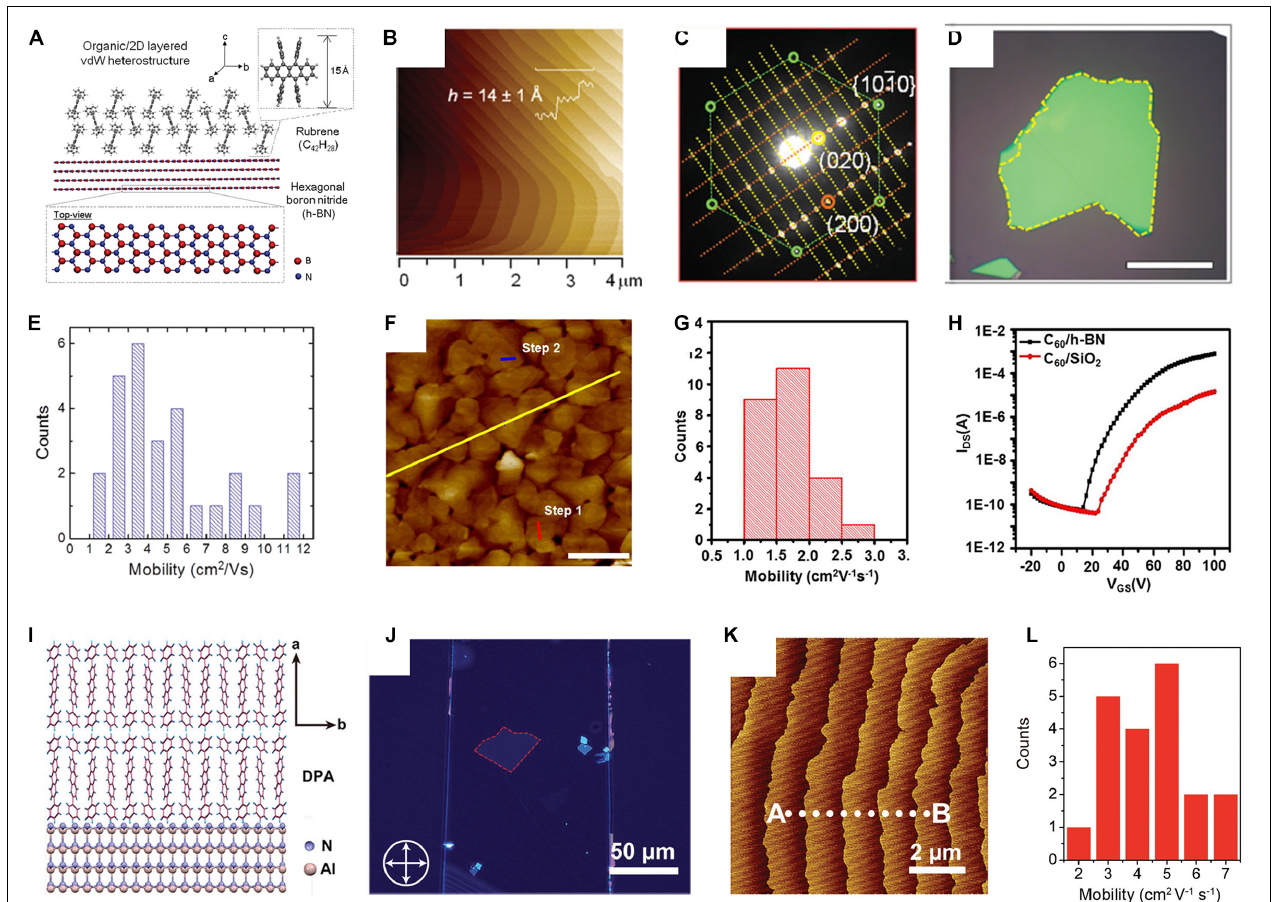
FIGURE 4 | OSCs/2D hybrid FETs with 2D materials as growth templates and insulating layers. (A) The packing mode of the rubrene/h-BN heterostructure. (B) AFM height image of the rubrene terraced film. A step height of 14 ± 1 Å is indicated. (C) Bright-field TEM image and selected-area electron diffraction pattern of the rubrene crystal grown on h-BN. The orange, yellow, and green circles corresponds to (200) rub , (020) rub , and h-BN planes, respectively. (D) Large single-crystalline domain of rubrene crystalline films grown on h-BN flakes by polarization optical characterization. The scale bar is 20 µ m. (E) Histogram of mobility of rubrene/h-BN OFET devices with graphene contacts. Reproduced from Lee et al. (2014) with permission from Copyright 2014 Wiley. (F) AFM height images for C 60 on CVD h-BN. (G) Histogram of electron mobilities of C 60 FETs on h-BN. (H) Comparison of transfer curves from C 60 FETs on h-BN vs. on SiO 2 . Reproduced from Lee et al. (2017) with permission from Copyright 2017 American Chemical Society. (I) Schematic packing mode image of DPA molecules on the AlN crystal surface. (J) Cross polarized optical micrographs of the DPA crystals. (K) AFM height images of the DPA crystal surface. (L) Statistical distribution of the saturation mobility of the OFETs based on the AlN/DPA crystalline heterostructures. Reproduced from Yang et al. (2018) with permission from Copyright 2018